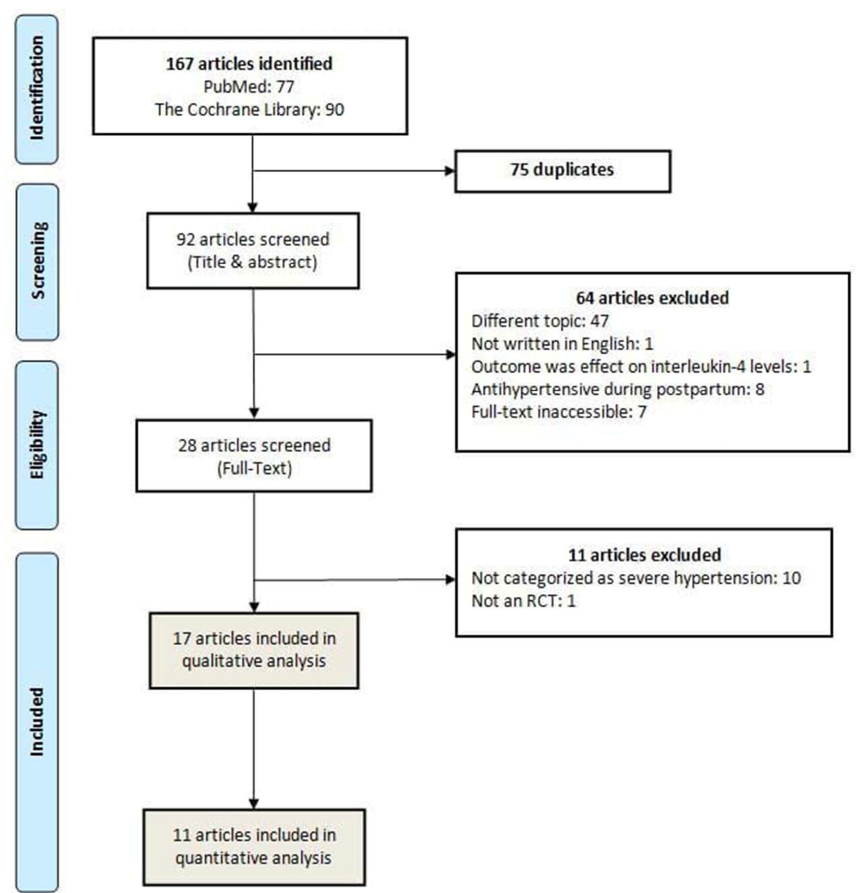
Figure 1. PRISMA flowchart: literature search results.